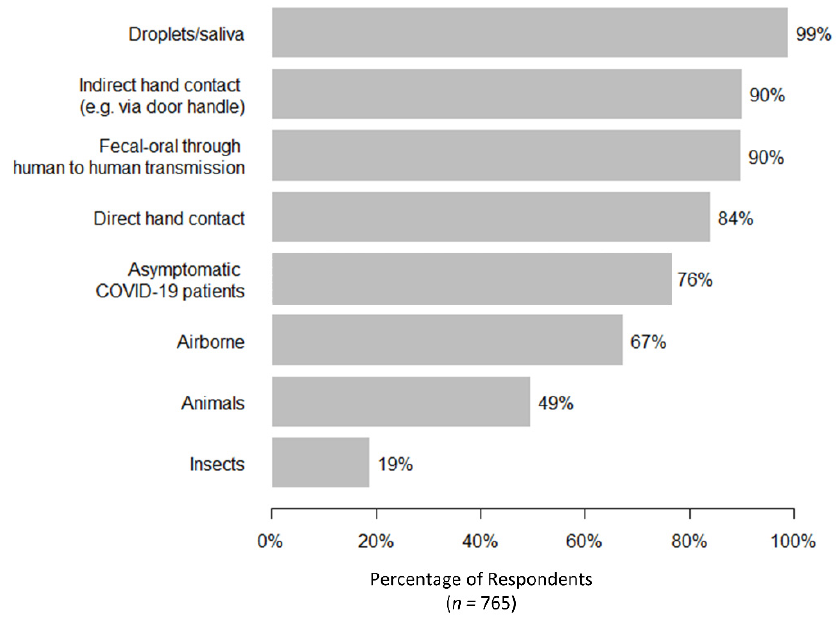
Figure 4. Reported believed transmission mode for COVID-19.